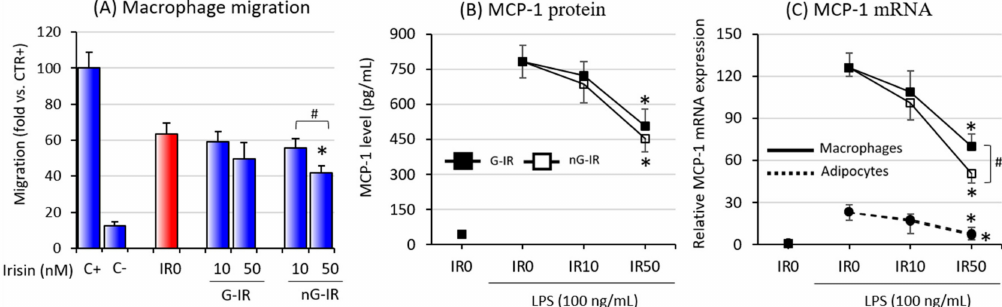
Figure 4. E ff ects of various forms of irisin (glycosylated (G-IR) or non-glycosylated (nG-IR)) on ( A ) RAW 264.7 macrophage migration to conditioned medium collected from adipocytes cultured in the presence of various concentrations of irisin (0, 10, or 50 nM) for 24 h. Normal medium was used as a negative control (C-); N- Formylmethionyl-leucyl-phenylalanine (fMLP) was used as a positive control (C + ). Irisin e ff ects on LPS-induced monocyte chemotactic protein 1 (MCP-1) release ( B ) and MCP-1 mRNA expression ( C ) by adipocyte–macrophage cocultures. Fully di ff erentiated 3T3 L1 adipocytes and RAW 264.7 macrophages were cultured in 12-well dishes with inserts (0.4- µ m pore size) for 6 h (mRNA expression, RT-PCR) or 24 h (MCP-1 release, ELISA tests) with or without the presence of irisin (0, 10, or 50 nM) administered 2 h before LPS stimulation (100 ng / mL). The results are expressed as mean + SD from five independent experiments. Statistical significances ( p < 0.05) were determined with the Duncan t -test. The asterisk (*) above the bar denotes statistically significant di ff erences in protein or mRNA levels calculated relative to the IR0 group, while the hash (#) denotes statistically significant di ff erences calculated between the G-IR and the nG-IR